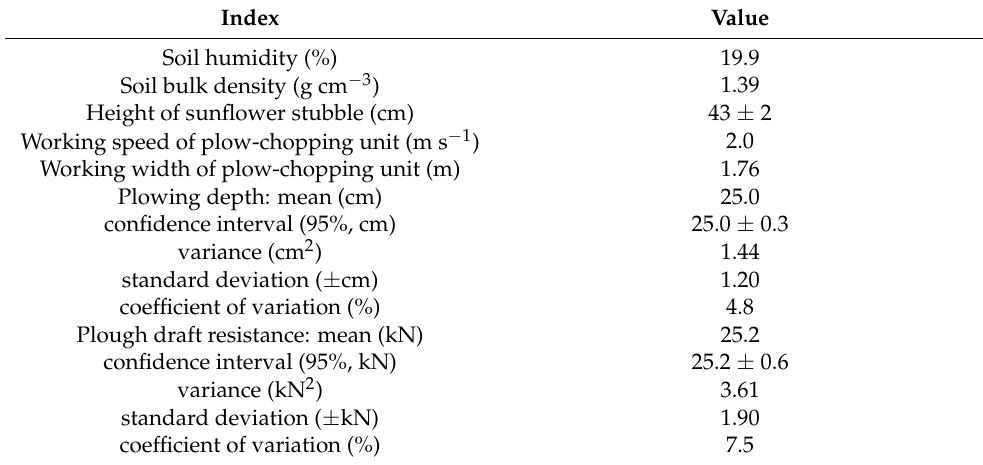
Table 2. The main characteristics of surface working